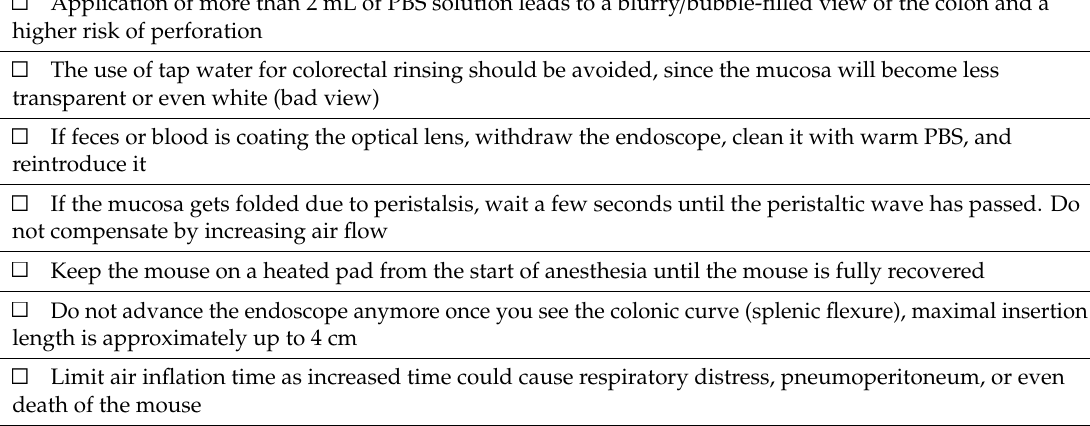
Table 3. Checklist of steps and tips for successful establishment of the current endoscopy-guided mouse model of colorectal cancer.